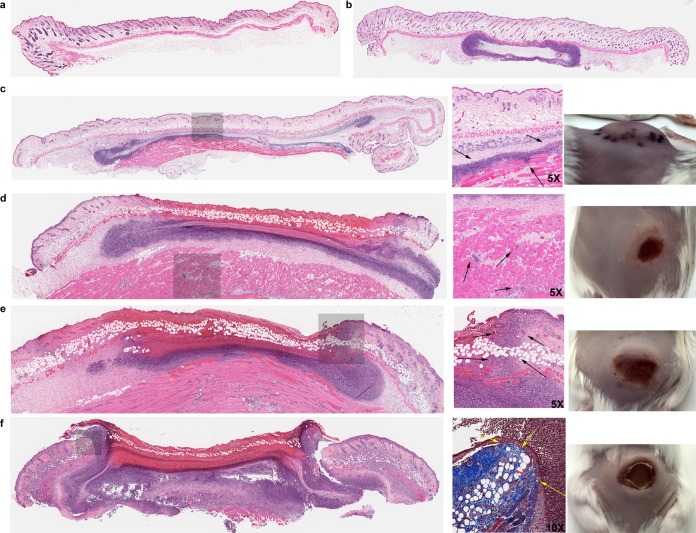
Histological sections and skin images of P. aeruginosa cutaneous infection on female CD-1 mice over several days. (a) Uninfected mouse skin tissue (including epidermis, dermis, adipose tissue, and thin skeletal muscle/panniculus carnosus). (b) Injection bubble underneath thin skeletal muscle surrounded by neutrophils and macrophages. (c to f) Infection progress after (c) 1, (d) 2, (e) 3, and (f) 7 days. Images show injected area with a zoom window (gray area), magnified location, and skin appearance (left to right). (c) On day 1, abundant neutrophils and macrophages were observed around the infection site that penetrated into the deep skeletal muscle tissue (arrows show deep inflammation and skeletal muscle damage). (d) Day 2 showed the extension of inflammation to the skeletal muscle (arrows) and necrosis of the overlying dermis. (e) On day 3, the inflammation extended further into the upper dermis (arrows). (f) On day 7, a large abscess with overlying crust/scab was formed. Adjacent reparative changes with granulation tissue, fibroblastic reaction, and epidermal reepithelialization were evident. Magnification shows Masson’s trichrome staining, highlighting fibroblastic proliferation around the edge of the necrotic tissue (yellow arrows).